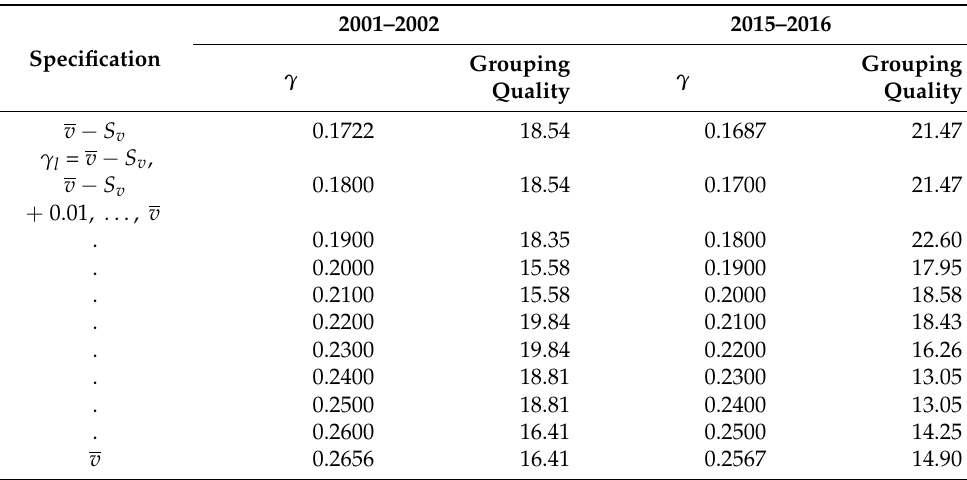
Table A3. The grouping quality measures for each γ value from the sequence in 2001–2002